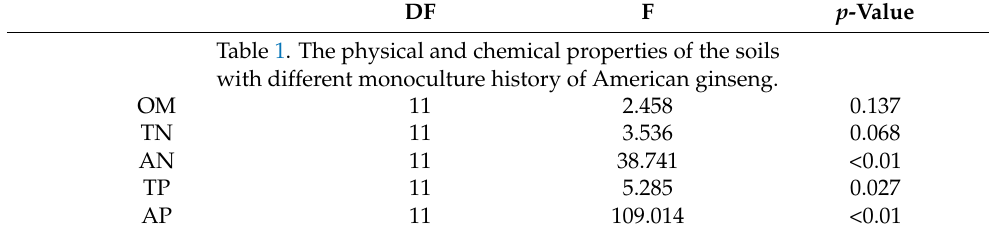
Table 2. The effect of phenolic acid concentrations on the growth of American ginseng pathogens.